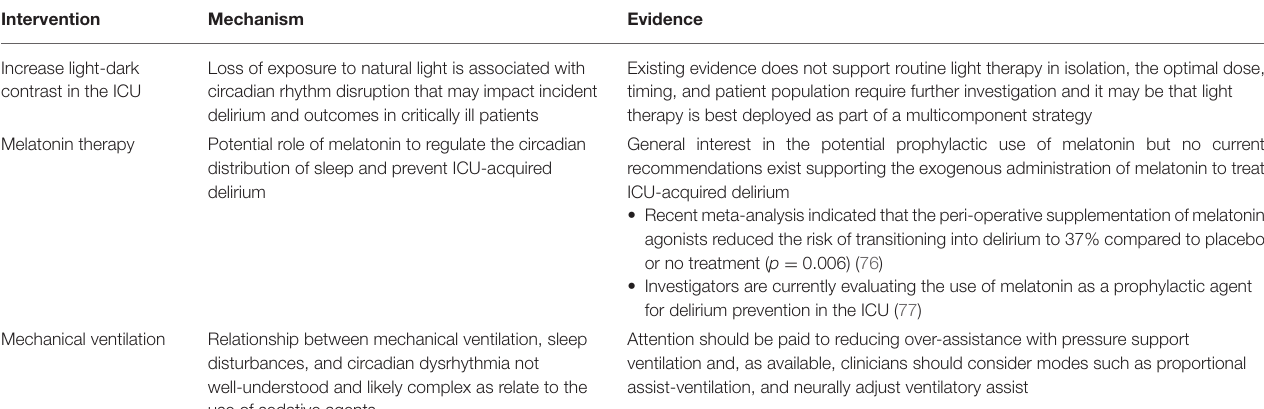
TABLE 1 | Strategies to improve sleep and realign circadian rhythm in the ICU.